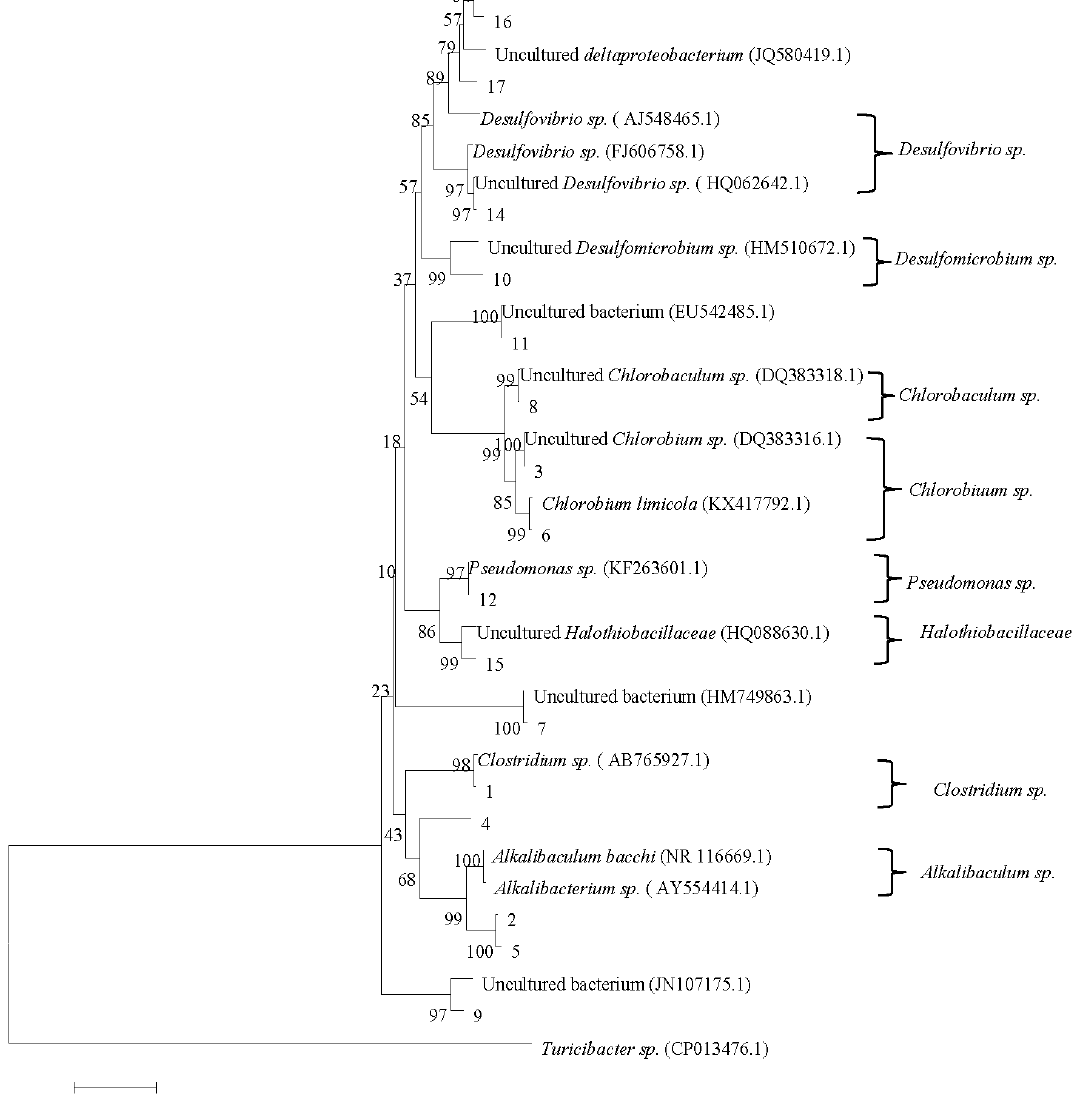
Figure 5. Microbial phylogenetic tree (the ruler length represents 10% divergence. The number of nodes represents confidence).